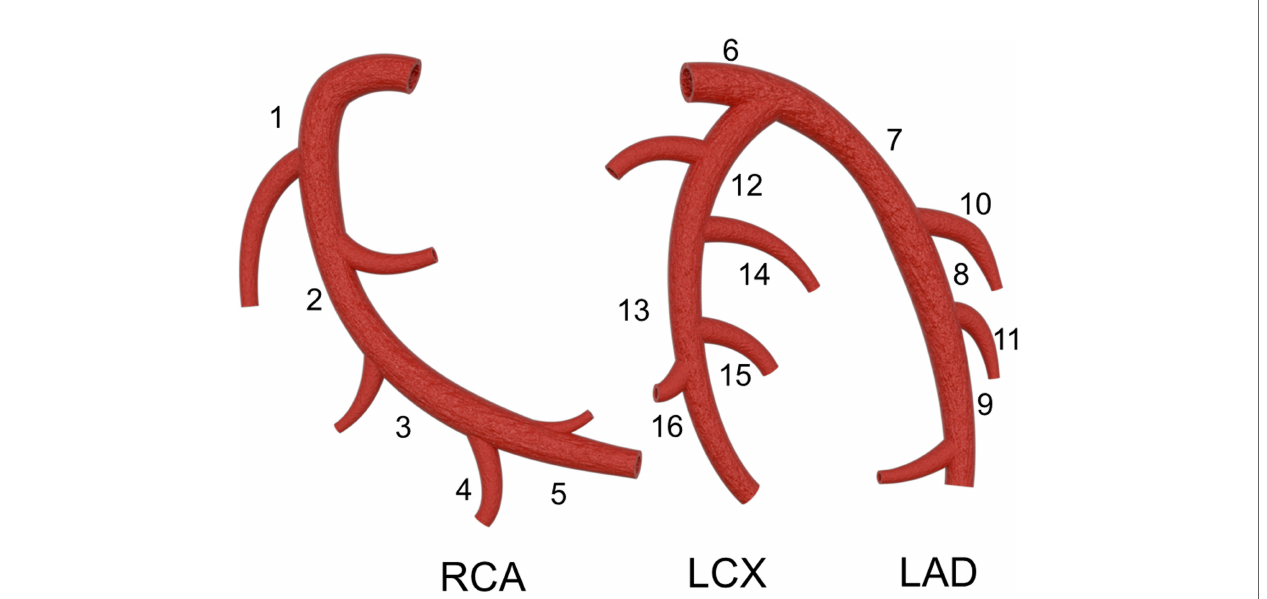
FIGURE 1 | Coronary artery segments: 1 proximal segment of right coronary artery (RCA); 2 middle segment of RCA; 3 distal segment of RCA; 4 right posterolateral artery; 5 posterior descending artery; 6 left main coronary artery; 7 proximal segment of left anterior descending artery LAD; 8 middle segment of LAD; 9 distal segment of LAD; 10 fi rst diagonal branch; 11 second diagonal branch; 12 proximal segment of left circum fl ex (LCX); 13 distal segment of LCX; 14 fi rst obtuse marginal branch; 15 second obtuse marginal branch; 16 left posterolateral artery.